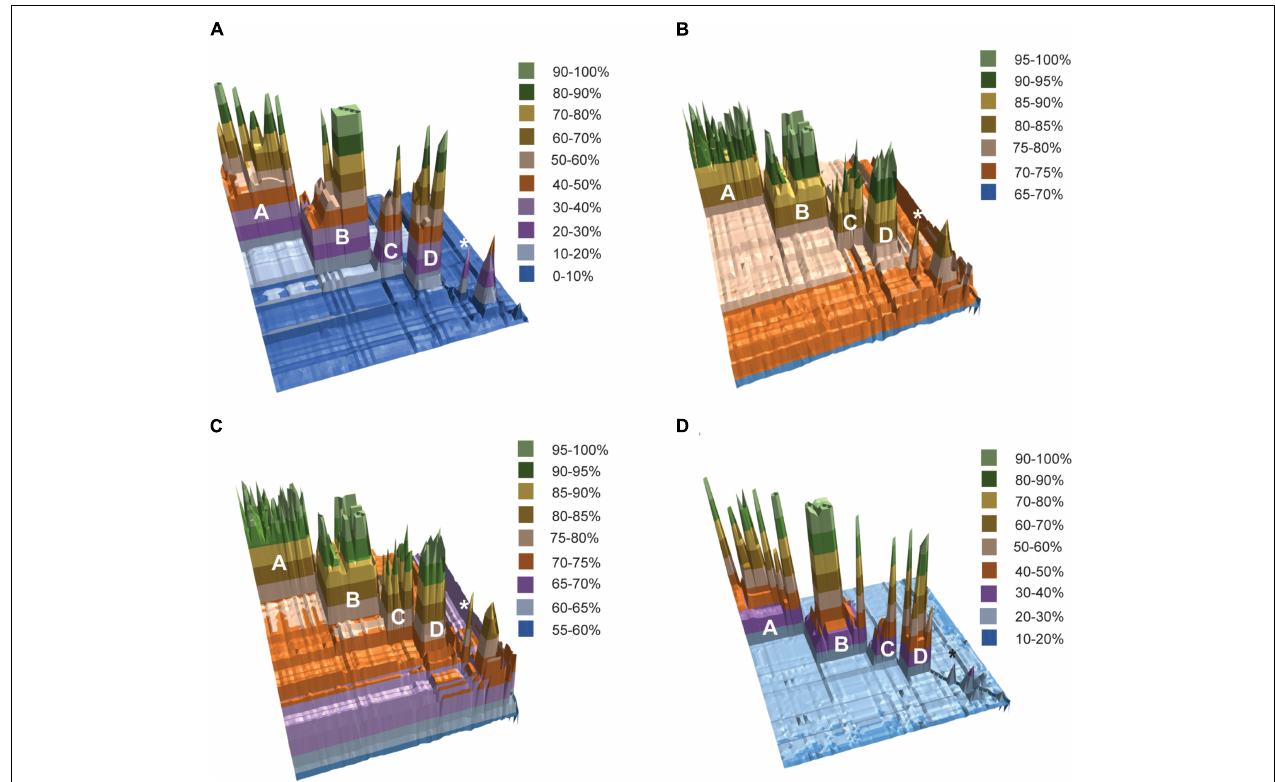
FIGURE 2 | 3D plots of pairwise matrices obtained from (A) fragmented BLAST searches (FBS values), (B) average nucleotide identities (ANIb values), (C) average amino-acid identities (AAI values) and (D) digital DNA-DNA hybridisation (dDDH values). The Amycolatopsis groups are labeled. The group of A. palatopharyngis DSM 44832 T and A. marina CGMCC4 3568 T is labeled with the star ( ∗ ) sign.